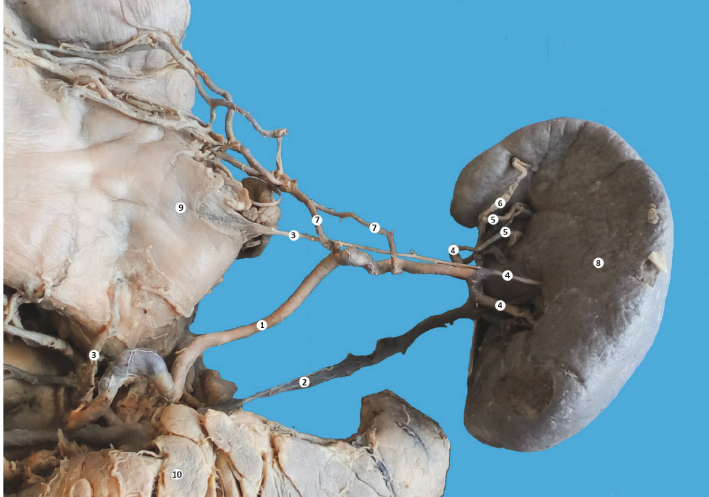
Figure 2: The branches of splenic artery. Macrospecimen (female, 63 years old). 1: splenic artery, 2: splenic vein, 3: posterior gastric artery, 4: splenic arteries of the first order 5: splenic arteries of the second order, 6: superior polar artery 7: left gastroepiploic artery 8: spleen, 9: stomach, and 10: